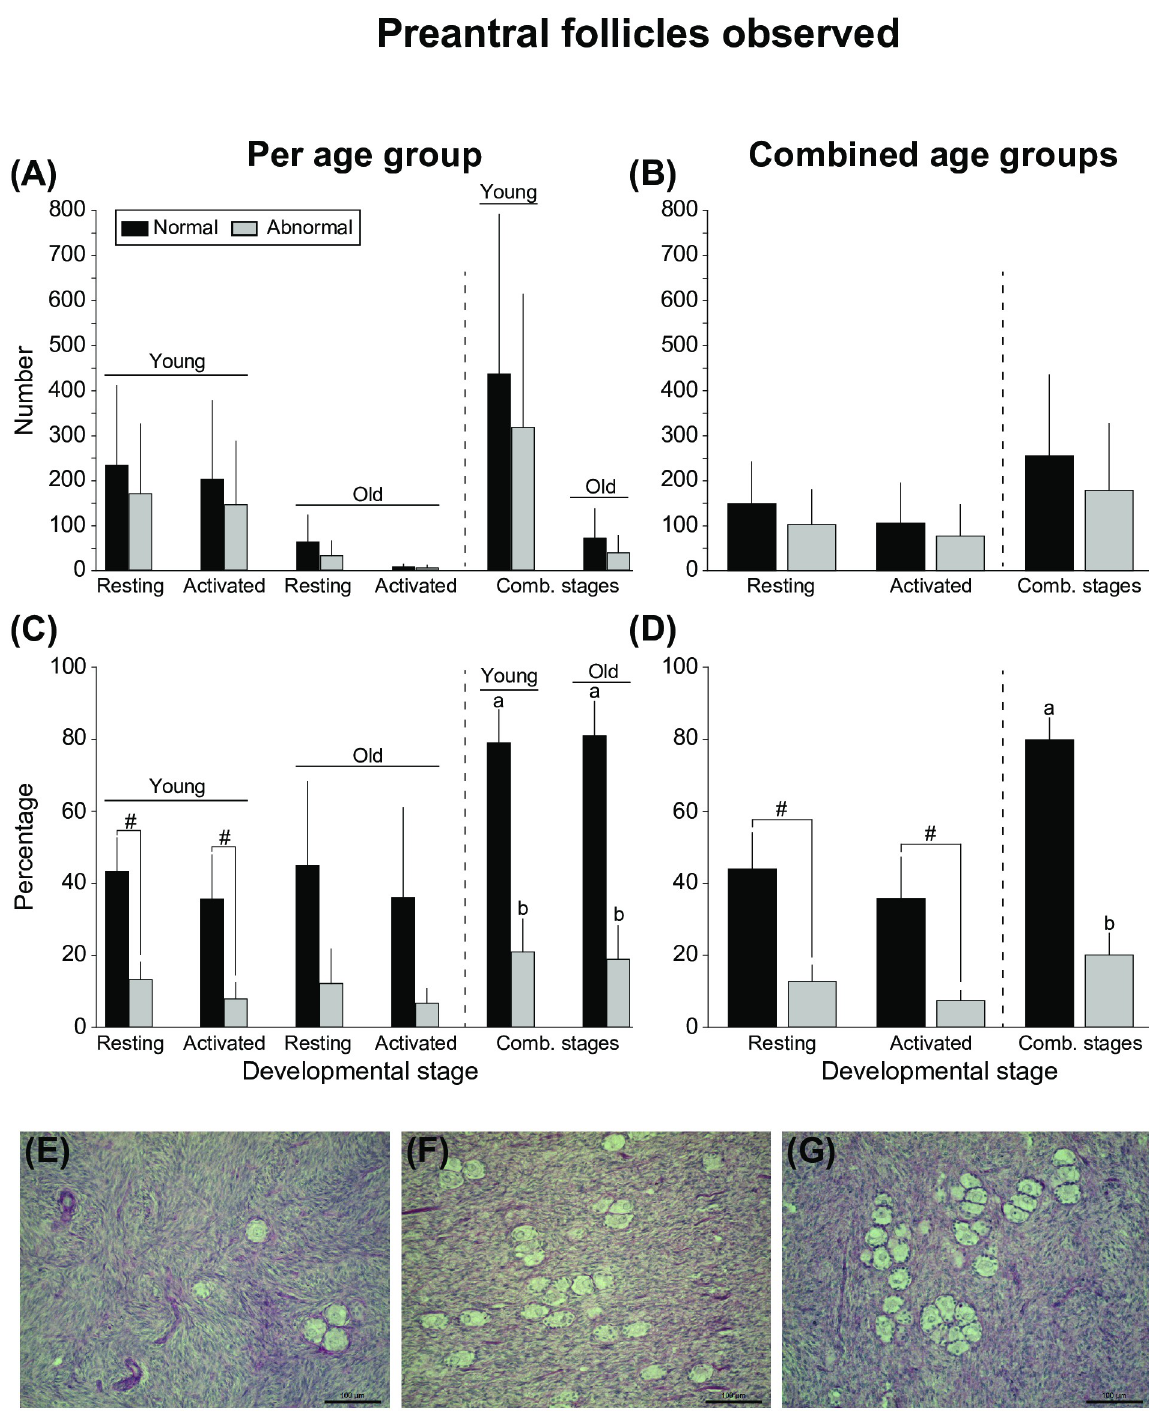
Fig 3. (A, B) Mean numbers ( ± SEM) and (C, D) mean percentages ( ± SEM) of observed resting and activated preantral follicles according to morphology considering (A, C) mare age and (B, D) when ages were combined. a,b Within the same age group or when ages were combined, and within the same developmental stage, values without a common superscript differed. # Indicates tendency ( P = 0.05–0.09) within the same developmental stage. No differences ( P > 0.05) were found regarding the number of observed follicles for any of the end points evaluated. Additionally, no differences ( P > 0.05) in percentages were observed within the young and old age groups between developmental stages or between age groups within the same morphology and developmental stage. All data were analyzed using one-way ANOVA after log 10 transformation for non-percentage data or arc sin square root transformation for percentage data. Comb., combined. (E–G) Representative